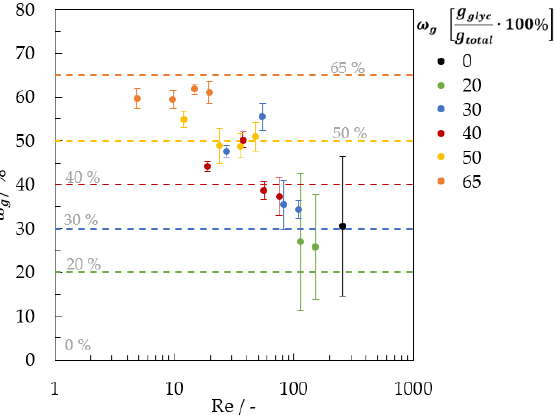
Figure 16. Comparison of measured glycerol mass concentration fields (mean glycerol mass concentration) and set glycerol mass concentration. Table 3. Relative errors of the glycerol mass concentration measurement shown in Figure 14 in comparison to the set glycerol mass